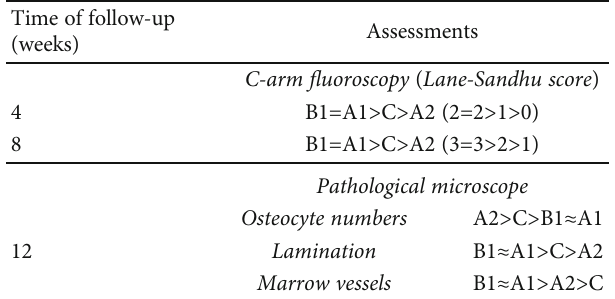
The defects (including control defect C of Tibia 2, treatment defects A1, A2, and B1) were sorted according in descending power to the results from the Lane-Sandhu score, numbers of osteocytes, maturation of bone lamination, and numbers of vessels in the marrow area. The treatment defects A1 and B1 had the closest